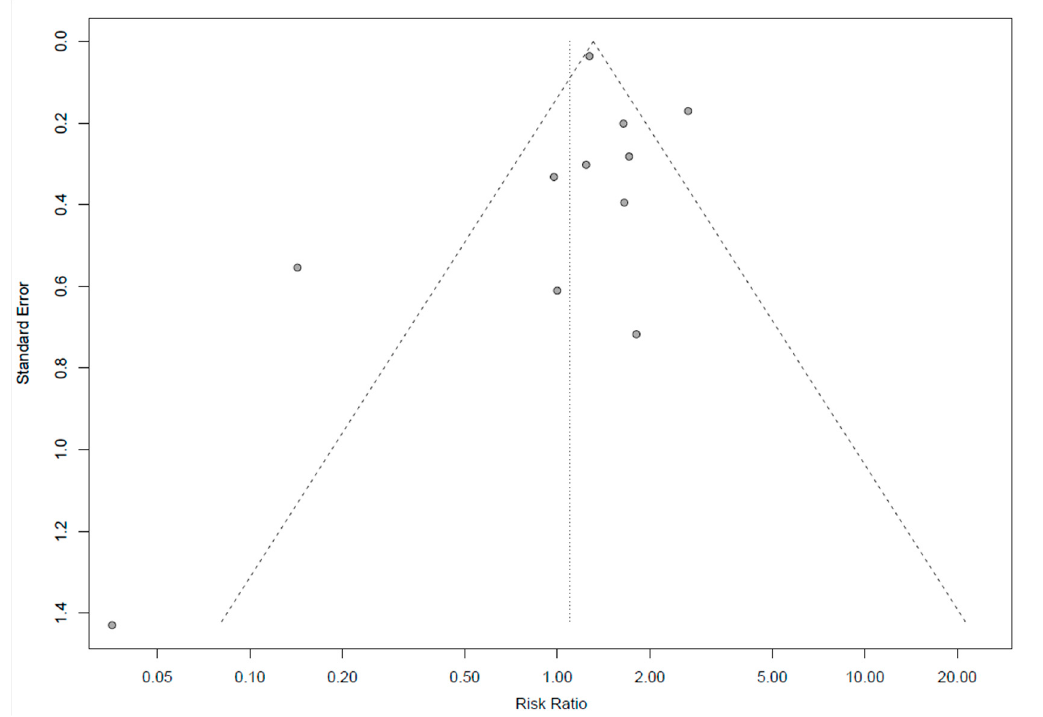
Figure 5. Funnel plot of recurrence rate for publication bias. Each point represents a separate study for the indicated association. OS, DFS and DFS had similar outcomes and are not shown.